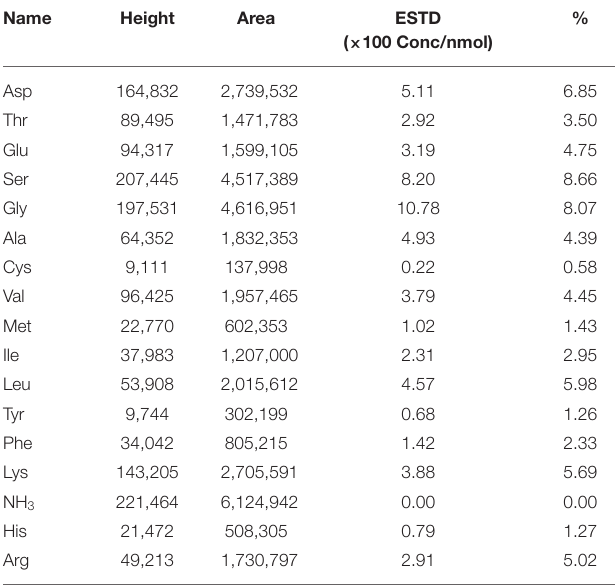
TABLE 1 | Amino acid composition of the sea cucumber intestinal peptide (SCIP) sample (g/100g